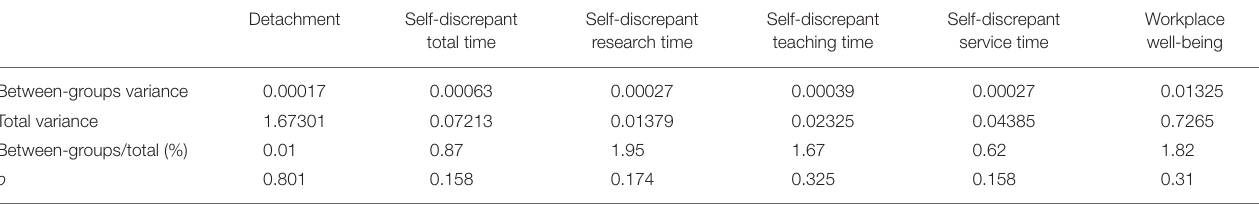
TABLE 1 | Variance components of all